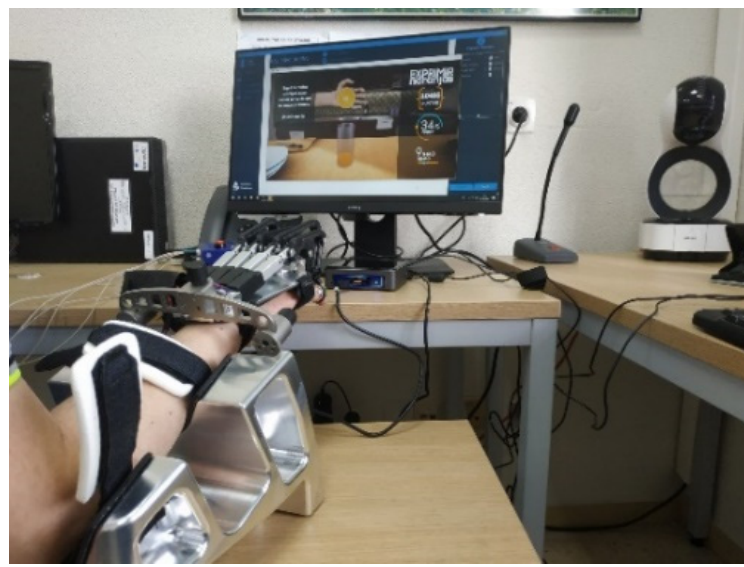
Figure 6. Setup for therapies with RobHand exoskeleton at HCUV hospital. Table 4. Protocol for patients performing therapy sessions with RobHand.